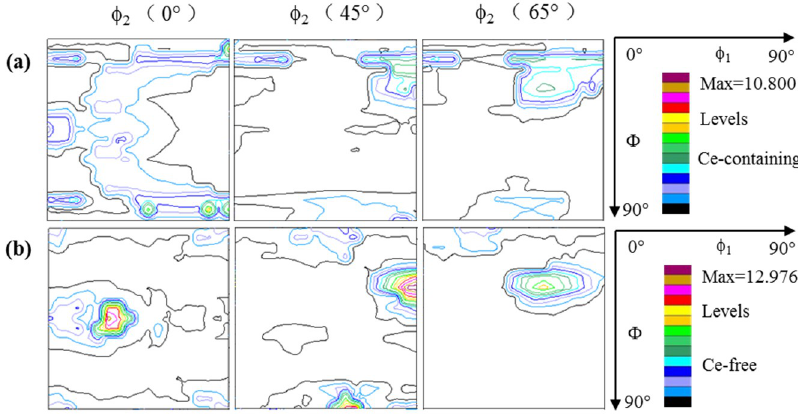
Figure 6. ODFs representative sections of the experimental alloys after the hot rolling stage. ( a ) Ce-containing alloy; ( b ) Ce-free alloy.